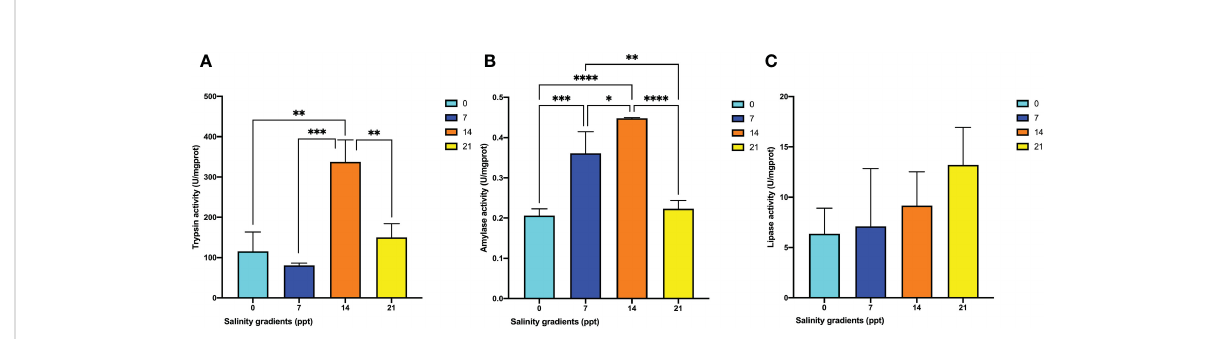
FIGURE 4 The changes of three digestive enzyme activities in the hepatopancreas of M. nipponense exposed to four salinity gradients. (A) Trypsin activities; (B) Amylase activities; (C) Lipase activities. * indicates the extent of signi fi cant difference (*: p < 0.05, **: p < 0.01, ***: p < 0.001, ****: p <